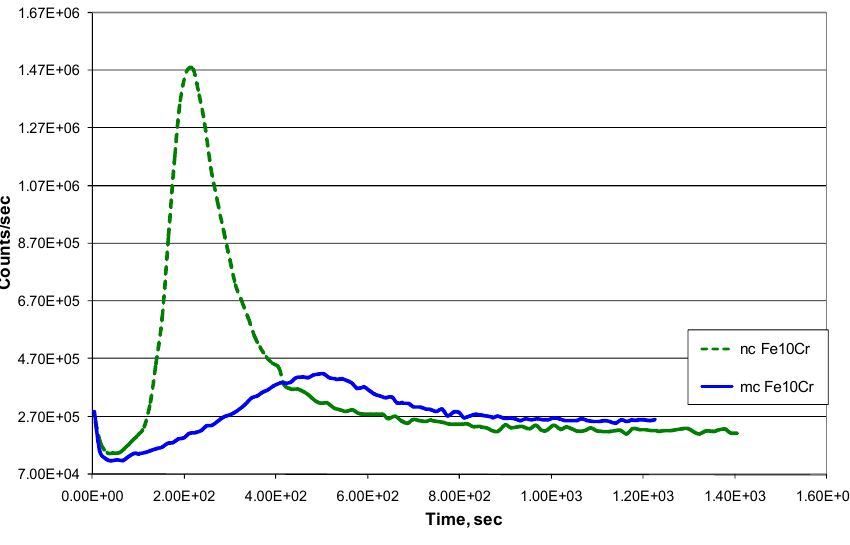
Figure 6. SIMS depth profiles for Cr in the oxide scale of Fe-10%Cr alloy with nanocrystalline (nc or NC) and microcrystalline (mc or MC) structures, oxidized for 120 h in air at 300 °C alloys. ([19], reproduced with copyright clearance).